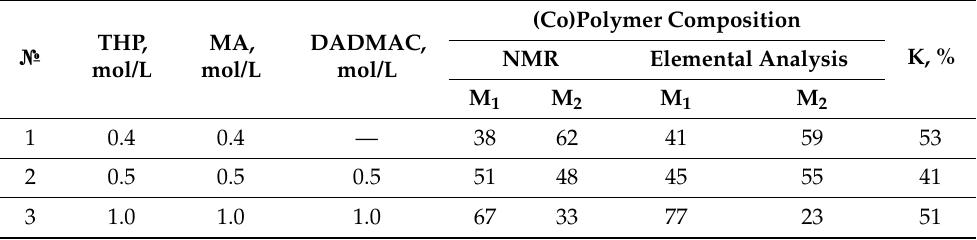
Table 4. Composition and yield of MTHP (co)polymerization products with MA and DADMAC